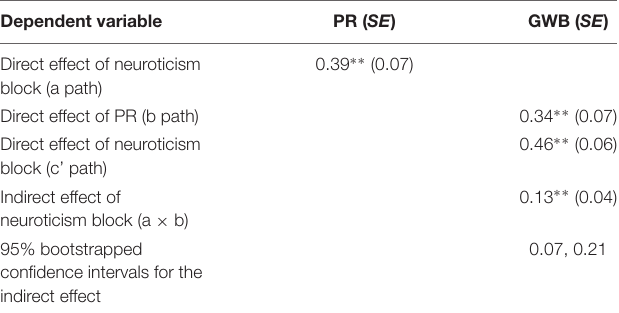
TABLE 6 | Direct, indirect, and total effects of neuroticism block and PR on GWB ( n = 161). Dependent